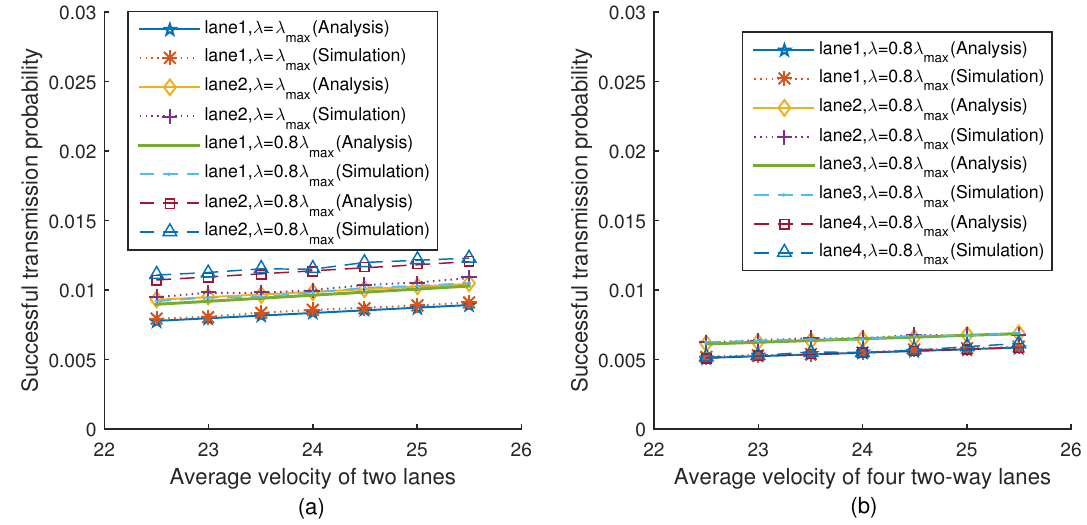
Figure 11. Successful transmission probability versus velocity ( q = 0.3).